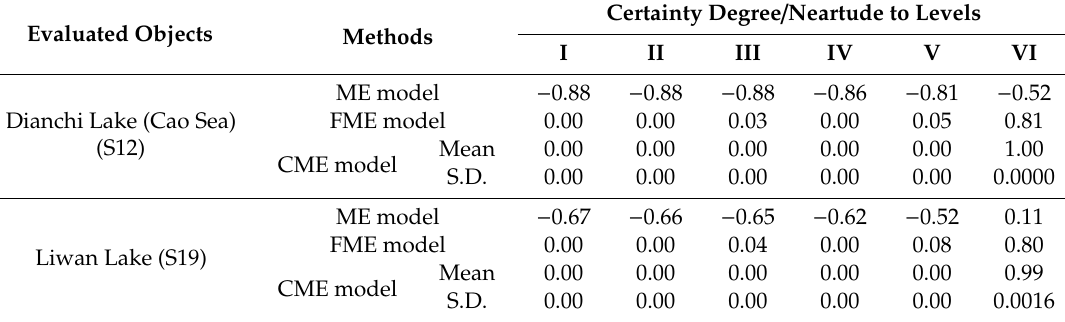
Table 7. Membership functions of three assessment methods of matter element (ME) model, fuzzy matter element model (FME) model, and cloud matter element (CME) model for Dianchi Lake (Cao Sea) (S12) and Liwan Lake (S19).